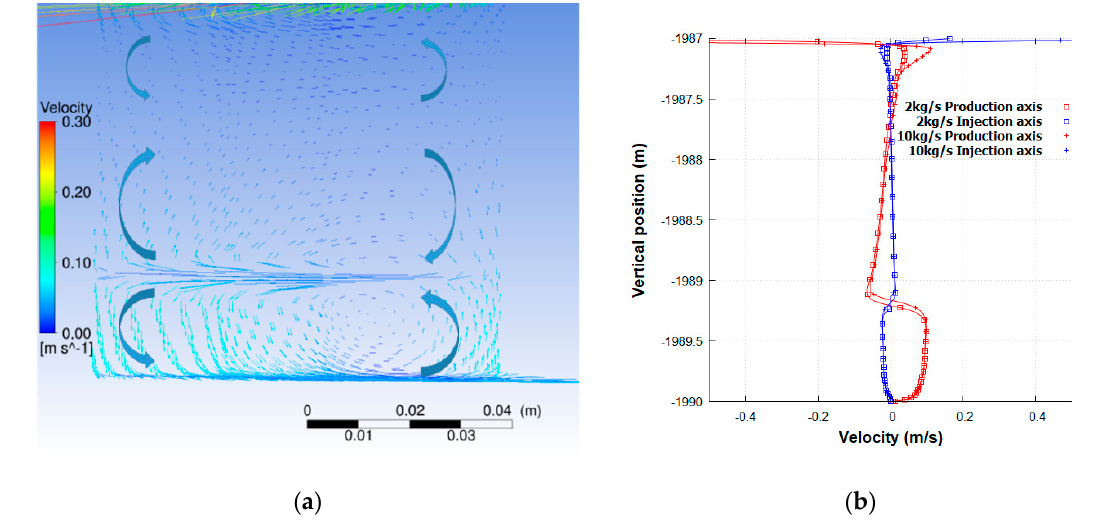
Figure 10. CFD results. ( a ) Velocity vectors at 2 kg / s using the IAPWS-IF97 properties below the internal tubing with the interpretation of the convective cells. The vertical axis has been scaled 40 times compared to the radial axis in order to visualize 3 m. ( b ) Axial velocity in the vertical axis (Production axis) and Injection axis (r = 0.06 m). The negative values indicate ascending water. The positive values stand for the descending